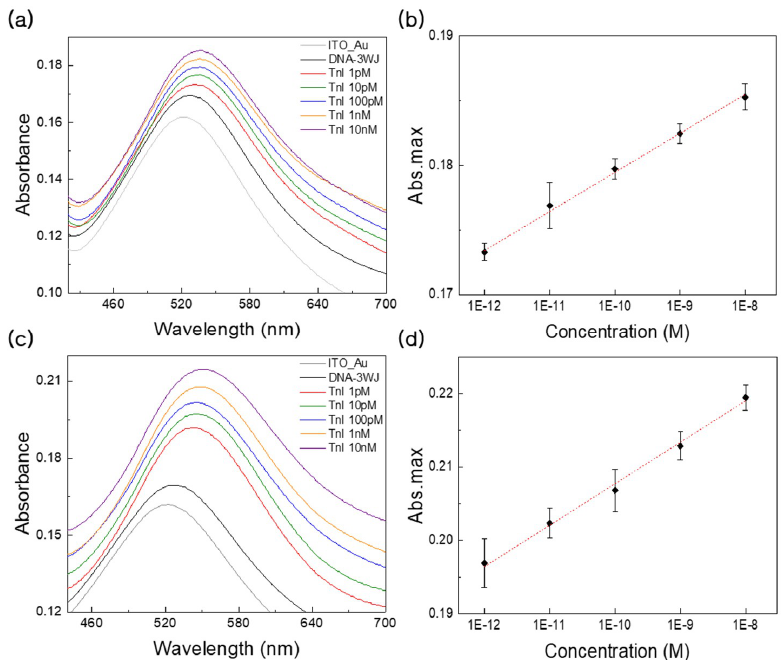
Figure 4. ( a ) Absorbance peak change at wavelength around 550 nm LSPR absorbance strength changes with different cTnI concentrations in PBS buffer, respectively. ( b ) Linear curves of the different concentration of cTnIs range from 1 pM to 10 nM. The detection limit of LSPR based biosensor for cTnI was 1 pM. ( c ) Absorbance peak change at wavelength around 550 nm LSPR absorbance strength changes with different cTnI concentrations in 10% diluted human serum, respectively. ( d ) Linear curves of the different concentration of cTnIs range from 1 pM to 10 nM. The detection limit of LSPR based biosensor for cTnI was 1 pM. Error bar represents relative standard